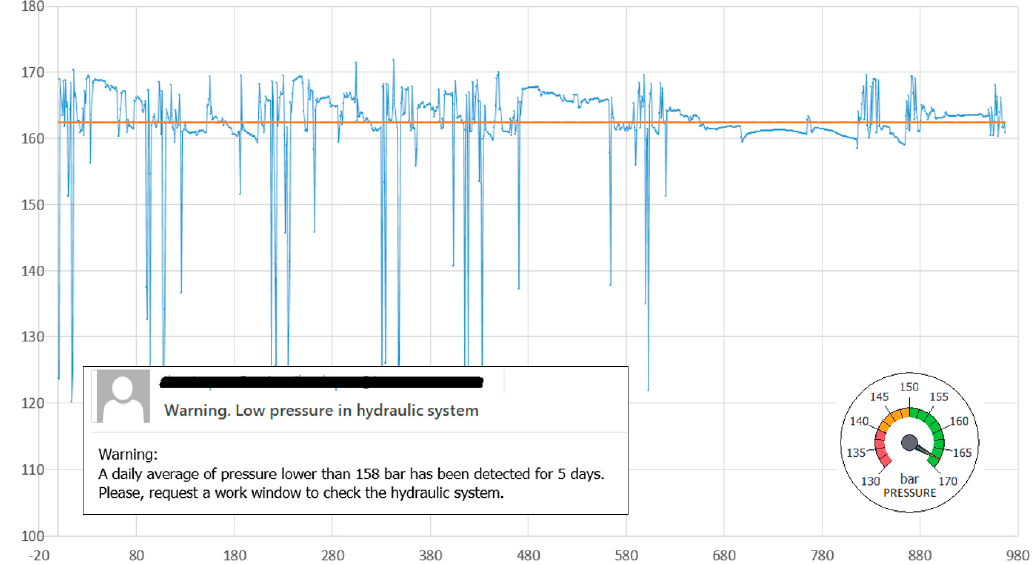
Figure 9. Captured data and the arithmetic mean value under standard conditions.